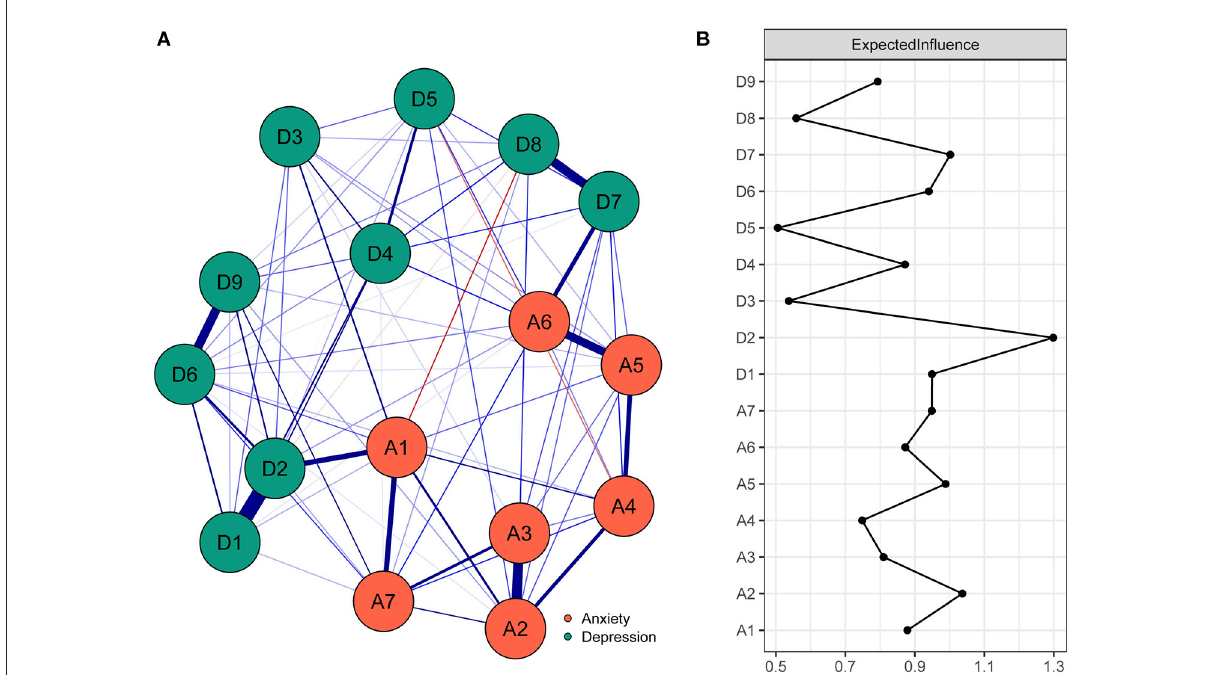
FIGURE1 The anxiety-depression network structure and the expected influence indices in the functionally impaired elderly. (A) The anxiety-depression network structure of the functionally impaired elderly. The nodes in the network represent symptoms of anxiety and depression, and the edges represent correlations of symptoms. Blue edges and red edges represent positive and negative correlations, respectively, and thicker edges represent higher correlations. (B) The expected influence indices in the anxiety-depression network of the functionally impaired elderly (raw score). A1, Nervousness or anxiety; A2, Uncontrollable worry; A3, Worry too much; A4, Trouble relaxing; A5, Restlessness; A6, Irritable; A7, Afraid something will happen; D1, Anhedonia; D2, Depressed or sad mood; D3, Sleep diculties; D4, Fatigue; D5, Appetite changes; D6, Feeling worthlessness; D7, Concentration diculties; D8, Psychomotor agitation/retardation; D9, Thoughts of